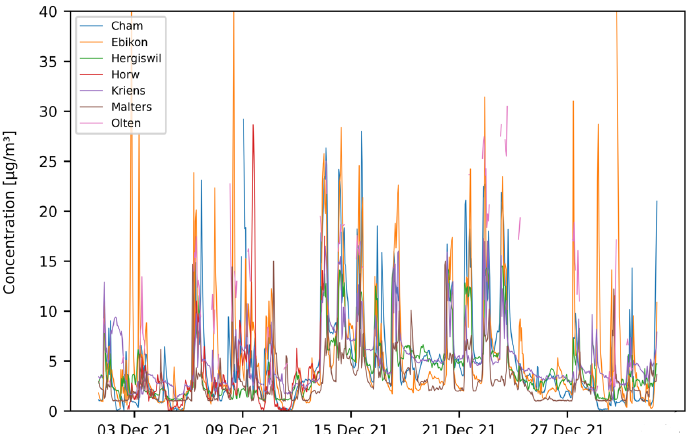
Figure 10. PM 10 hourly mean data recorded with mobile pilot sensor-boxes in the period from 1 July 2021 to 30 July 2021.